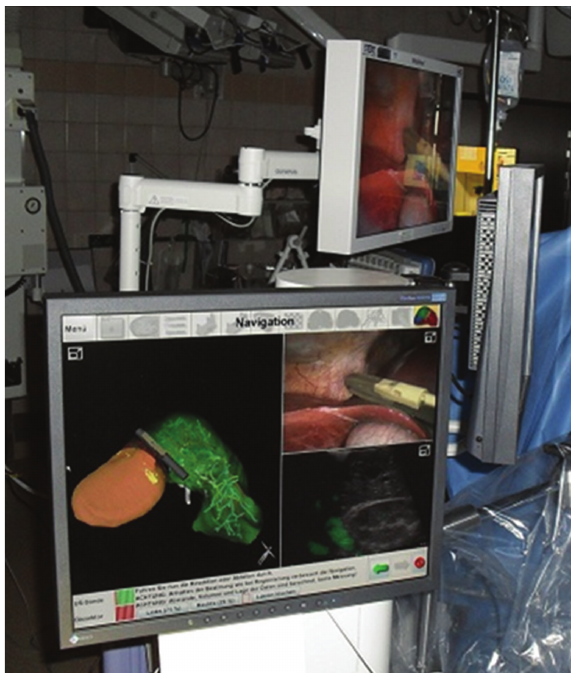
Figure 7: LapAssistent placed intraoperatively on the right patient side; simultaneous laparoscopic and ultrasound scenes are described